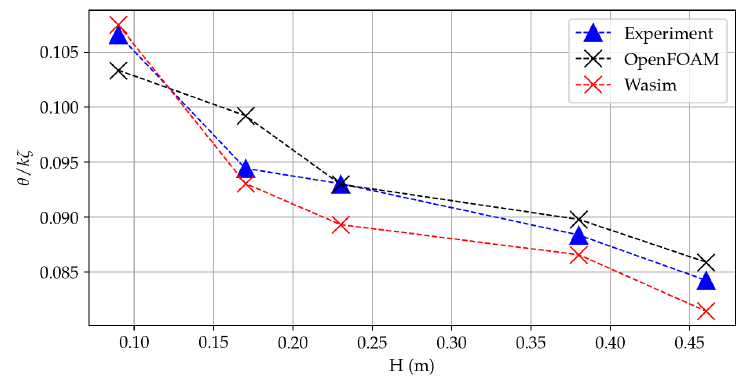
Figure 17. The nondimensional amplitude of pitch response for the 6750 TEU containership.